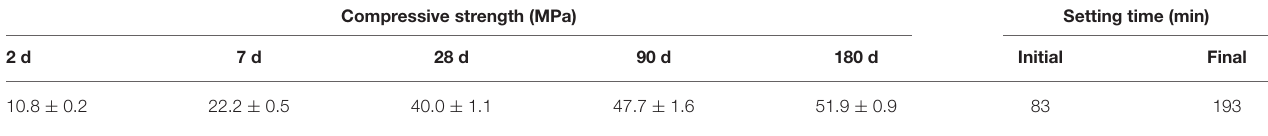
TABLE 2 | Mortar strength (4 × 4 × 16 cm 3 specimens) and setting times for “alkaline-belite” hybrid cement. Compressive strength (MPa) Setting time